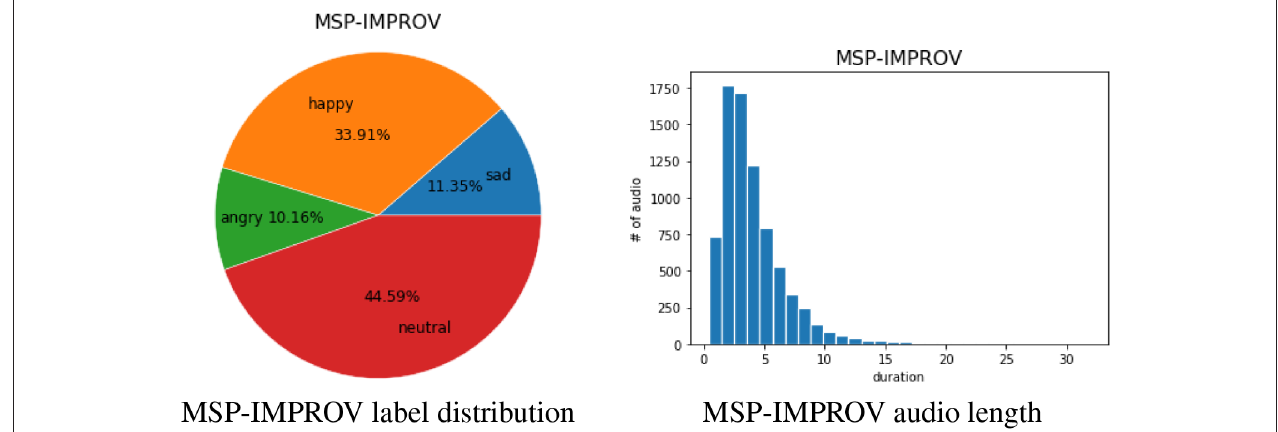
FIGURE 2 | The 4-class emotion label distribution and the audio length distribution of MSP-IMPROV